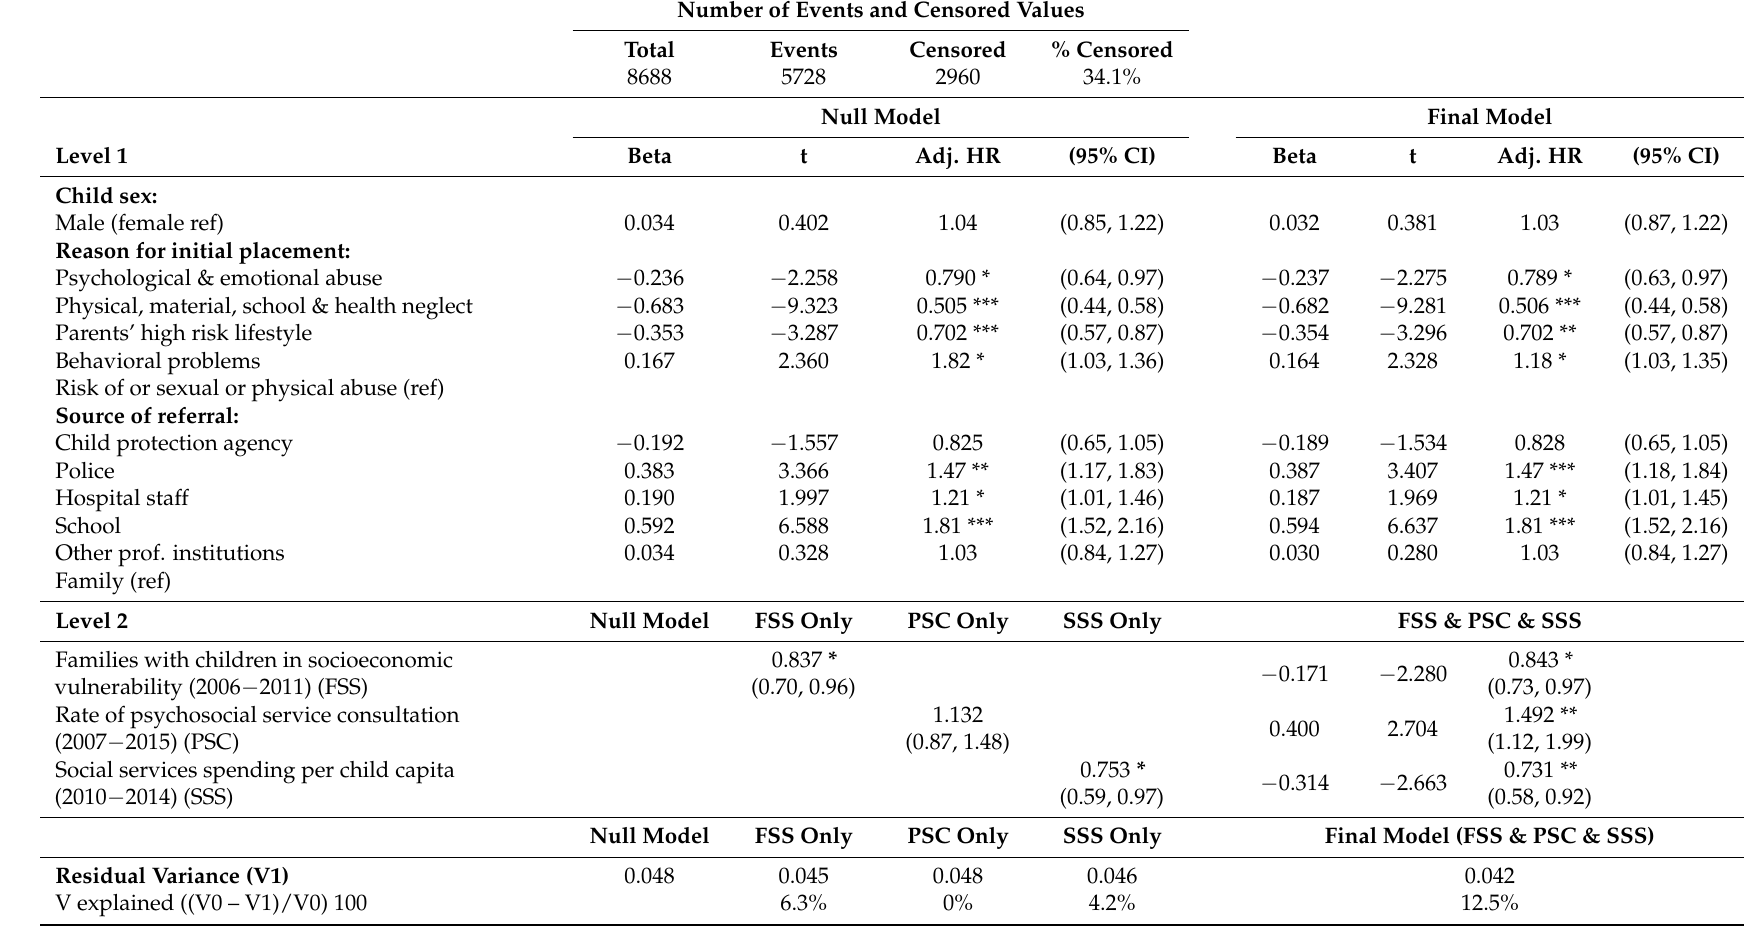
Table 4. Multilevel Cox proportional hazard model of family reunification for placed children age 5 to 11